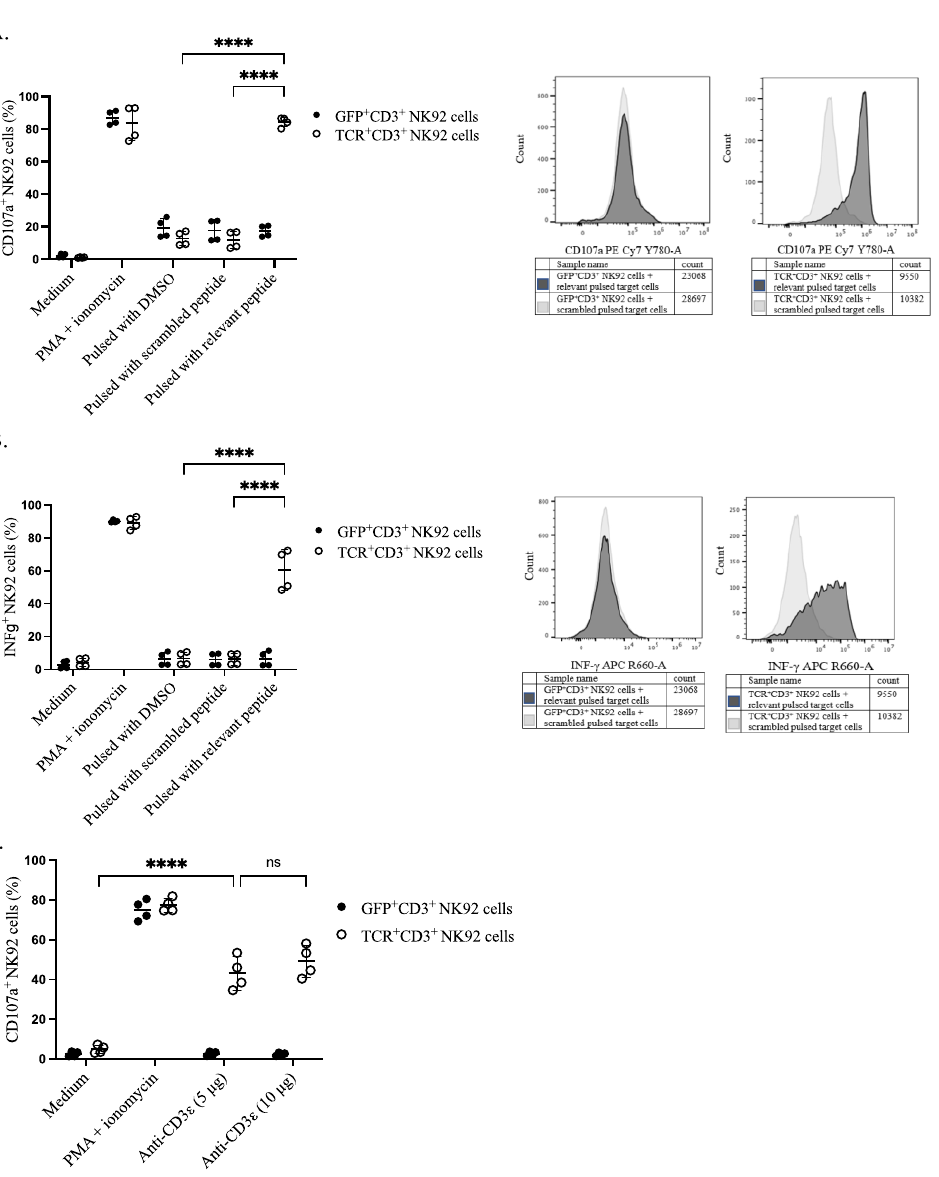
Figure 4. Functional properties of NK92 cells. NK92 cells were incubated either with prior pulsed target cells at an E:T ratio of 1:1 or with anti-CD3 ε for 4 h. Golgistop was added after the first-hour incubation. CD107a conjugated PE-Cy7 antibody was present throughout the assay. Cells and supernatant were harvested for surface and intracellular staining on the same cells for flow cytometry. NK92 cells were separated from target cells by gating on CD56 + cells. ( A ) Percentage of CD107a positive NK92 cells after incubating with target cells, two independent experiments were performed. The **** indicates a statistically significant p < 0.0001. ( B ) Percentage of IFNγ positive NK92 cells after incubating with target cells, two independent experiments were performed. The **** in- dicates a statistically significant p < 0.0001. ( C ) Comparative assessment of transgene responses upon CD3ε agonistic treatm ent. The **** indicates a statistically significant p < 0.0001, and ns indicates not significant.